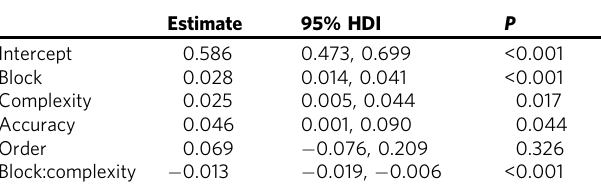
Table 2 Results of the Bayesian-estimated linear mixed effects regression model predicting neural compression within the peak voxel of the vmPFC region depicted in Fig. 2b.